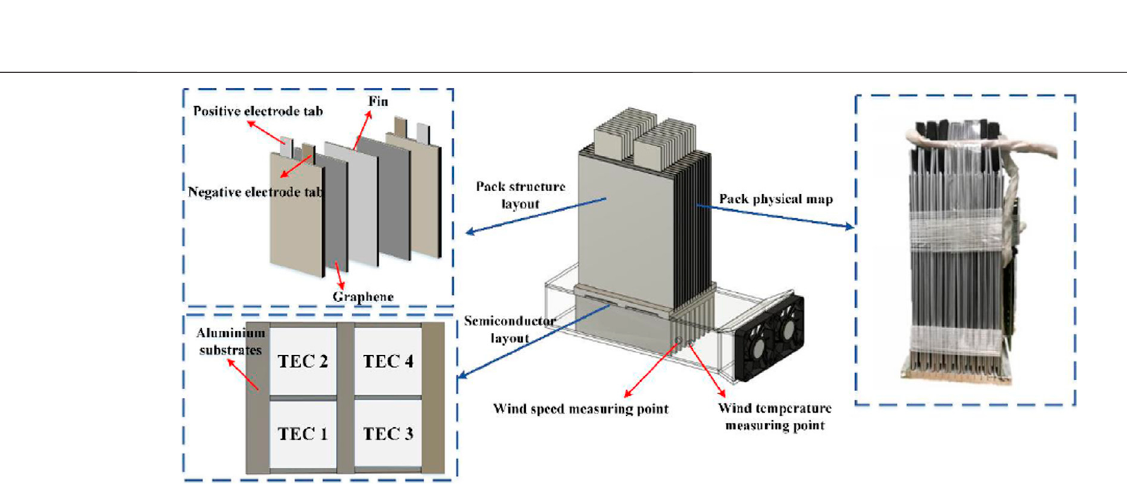
FIGURE 7 | Structure of the 48 V battery pack ’ s semiconductor cooling system.